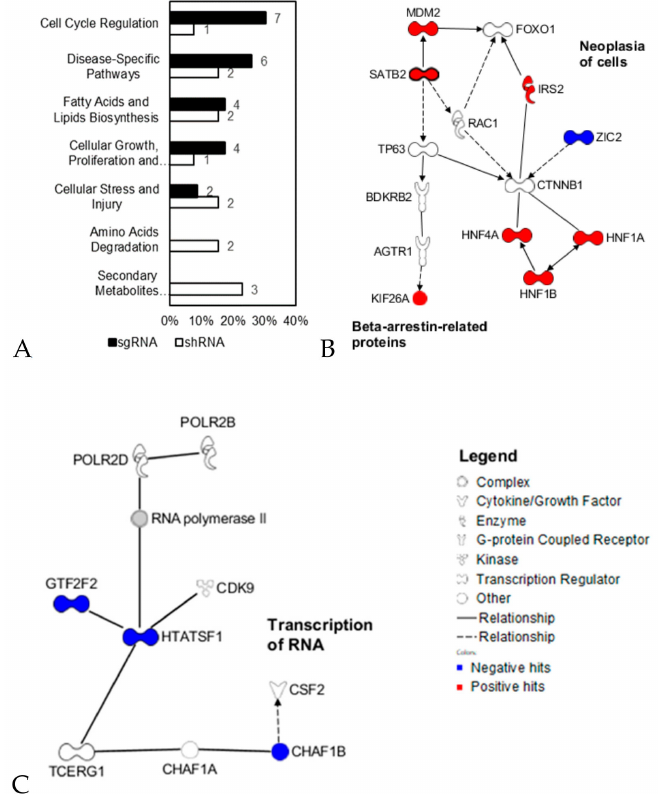
Figure 5. Functional category and network analyses of predictivity and descriptivity hit genes from Figure 4. ( A ) Distribution of functional categories enriched in shRNA and sgRNA hit